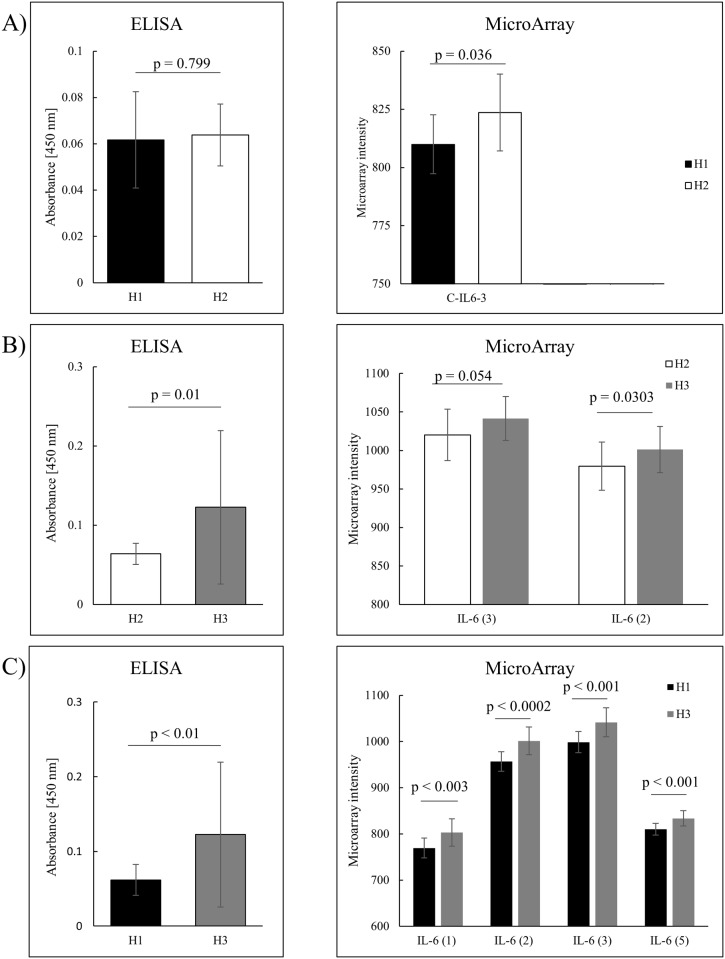
Validation of antibody microarray data using an orthogonal method (ELISA).A) Histological grade 1 vs. 2 based on ELISA data (left panel) and antibody microarray data (right panel). B) Histological grade 2 vs. 3, based on ELISA data (left panel) and antibody microarray data (right panel). C) Histological grade 1 vs. 3, based on ELISA data (left panel) and antibody microarray data (right panel). In all comparisons, a Welsh t-test was used to evaluate the level of significance.